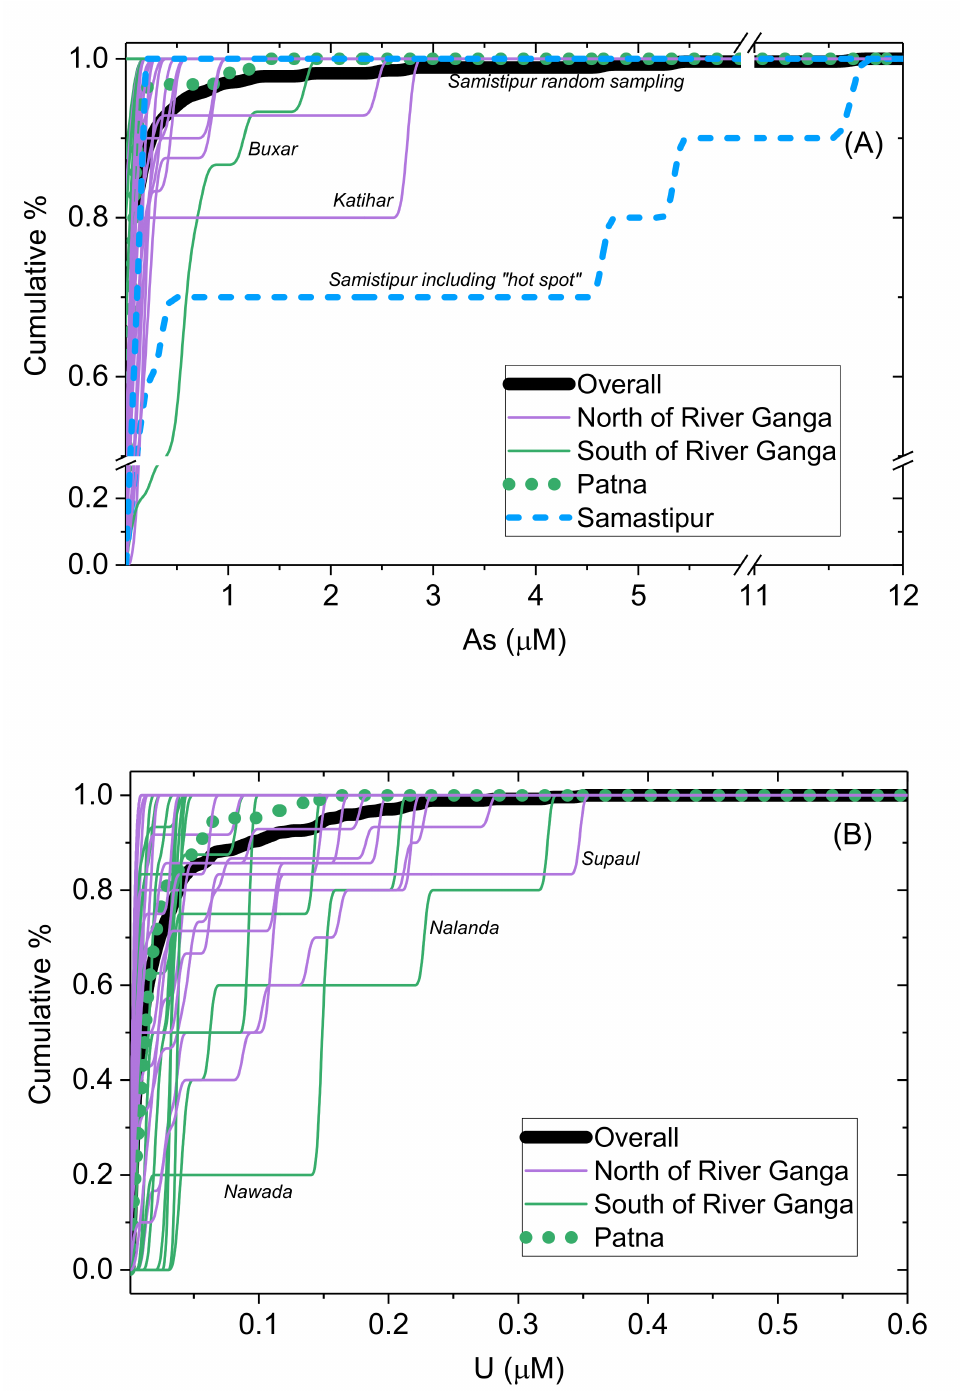
Figure 8. Cumulative distribution curves at a district level for ( A ) As and ( B ) U. Overall distribution is shown in bold black line; Patna in green dotted line. On ( A ), two lines for Samastipur (dashed blue line) are shown, indicating one containing random sampling only and another with the inclusion of samples from a known As “hot spot” (see discussion in Section 3.2). Colours indicate if districts are located north (purple) or south (green) of the River